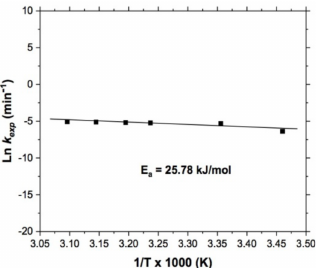
Figure 7. Copper leaching. Effect of temperature, E a = 25.78 kJ/mol. Experimental conditions: (cid:104) (cid:105) S 2 O − 2 = 0.5 mol/L, 750 RPM, pH = 10, P/P O2 = 1 atm and 5 g of 3